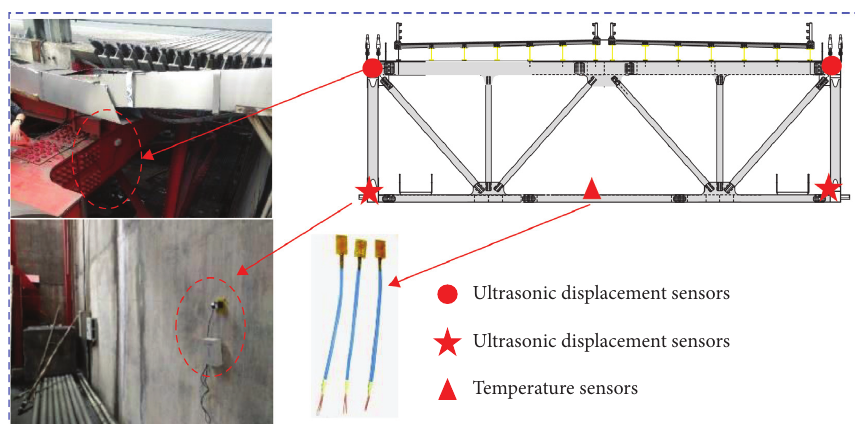
Figure 2: Monitoring sensors in the truss-girder section at the girder ends. Table 2: Instrumentations applied on Aizhai Bridge.